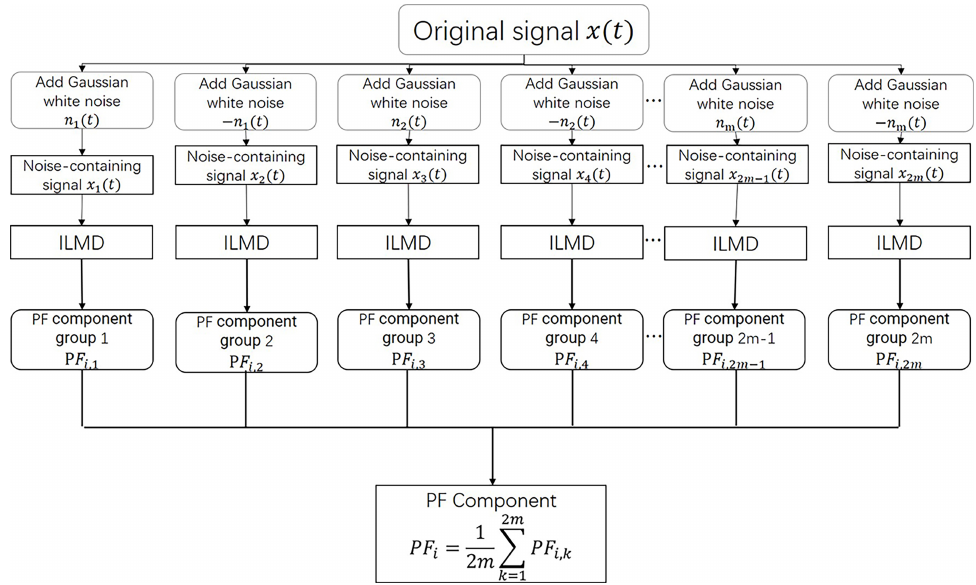
Figure 2. Flow chart of Interpolate CELMD.